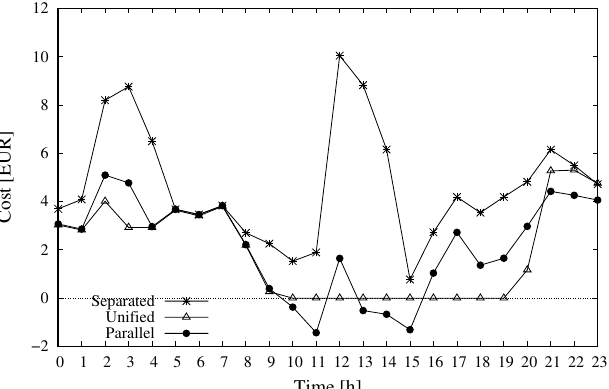
Figure 12. Case B. Daily cost profile of the community, considering the energy exchanged with the external grid. Comparison among the Separated, Unified, and Parallel approaches. Table 8. Case B. The daily cost for a community of 100 users. Separated